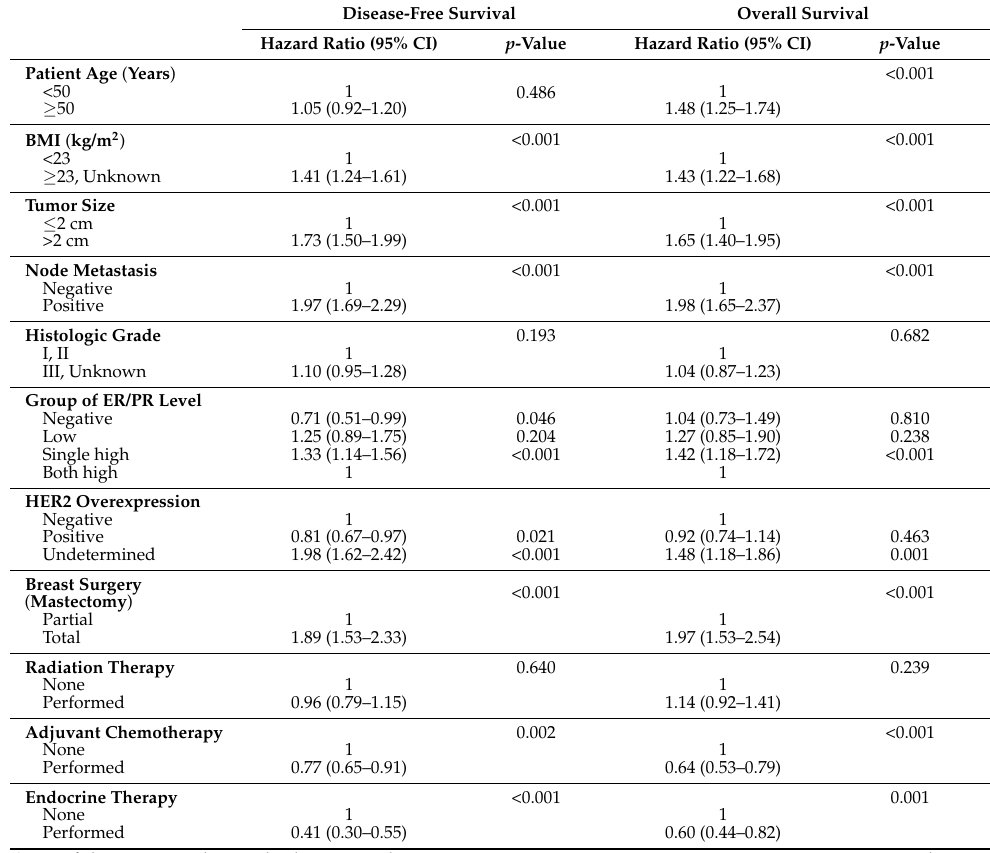
Figure 6. Kaplan–Meier survival analysis according to the expression level of the hormone receptor. ( A ) Disease-free survival and ( B ) overall survival. Table 2. Multivariate Cox regression analysis of disease-free survival and overall survival by baseline